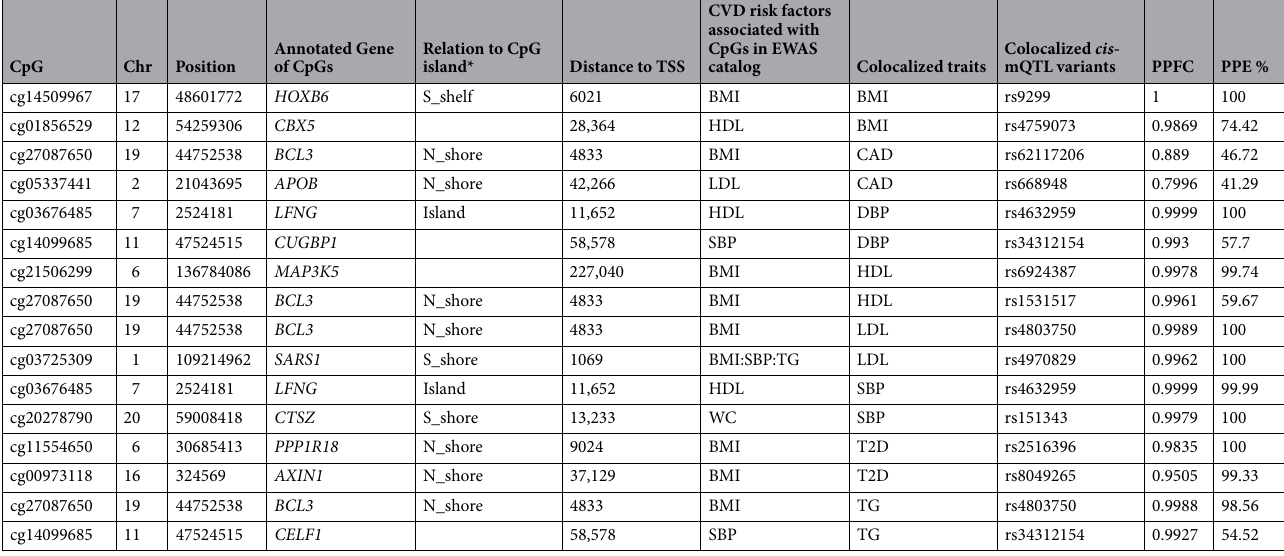
Table 2. Top colocalization analysis results for CVD risk factor-associated CpGs. The top two colocalization results are presented for each outcome trait of interest (BMI, SBP, DBP, HDL, LDL, TG, T2D, & CAD). BMI, body mass index; SBP, systolic blood pressure; DBP, diastolic blood pressure; DBP, high density lipoprotein cholesterol; LDL, low density lipoprotein cholesterol; TG, triglyceride; T2D, type 2 diabetes; CAD, coronary artery disease; PPFC, posterior probability of colocalization; PPE, proportion of PPFC explained by the listed SNP. *Shore is region from 1 to 2 Kb away from a CpG island and shelf is located at 2–4 Kb from a CpG island. Prefixes N_ and S_ represent north (i.e., upstream) and south (i.e., downstream) regions relative to a CpG island. TSS, transcription start